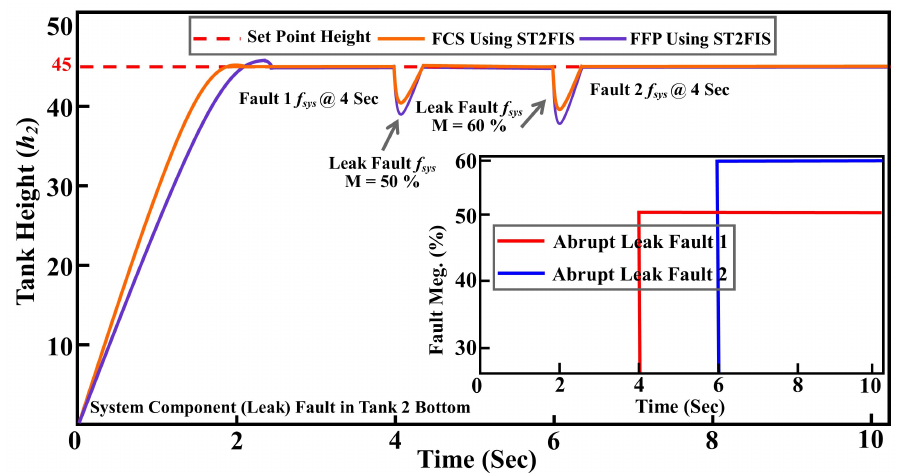
Figure 17. Comparative results of TTCFNLC process subject to random noise in the fuzzy controller and system component (leak) fault in TTCFNLC process using fuzzy CS and FP